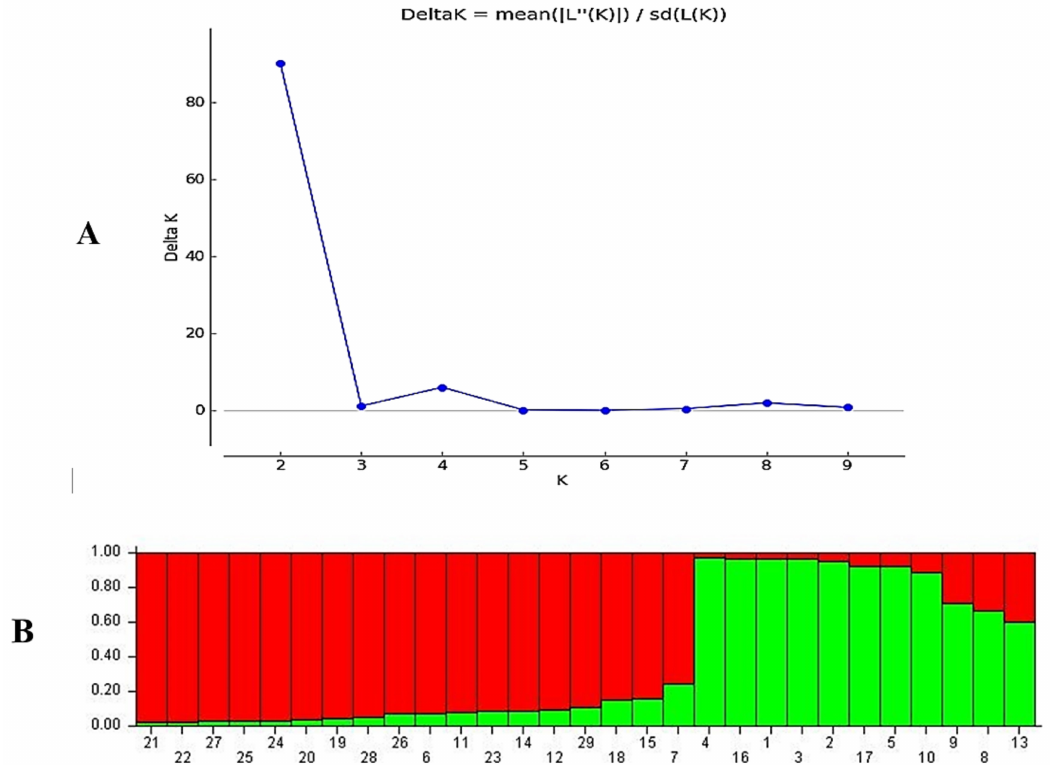
Figure 5. Genetic structure based on Bayesian clustering of eight populations (29 genotypes); ( A ): K-value, the number of clusters (K) was plotted against ∆ K, which showed a sharp peak at K = 2. ( B ): genetic clustering estimated (K = 2) which indicated that the populations can be grouped into two subgroups using STRUCTURE 2.3.4